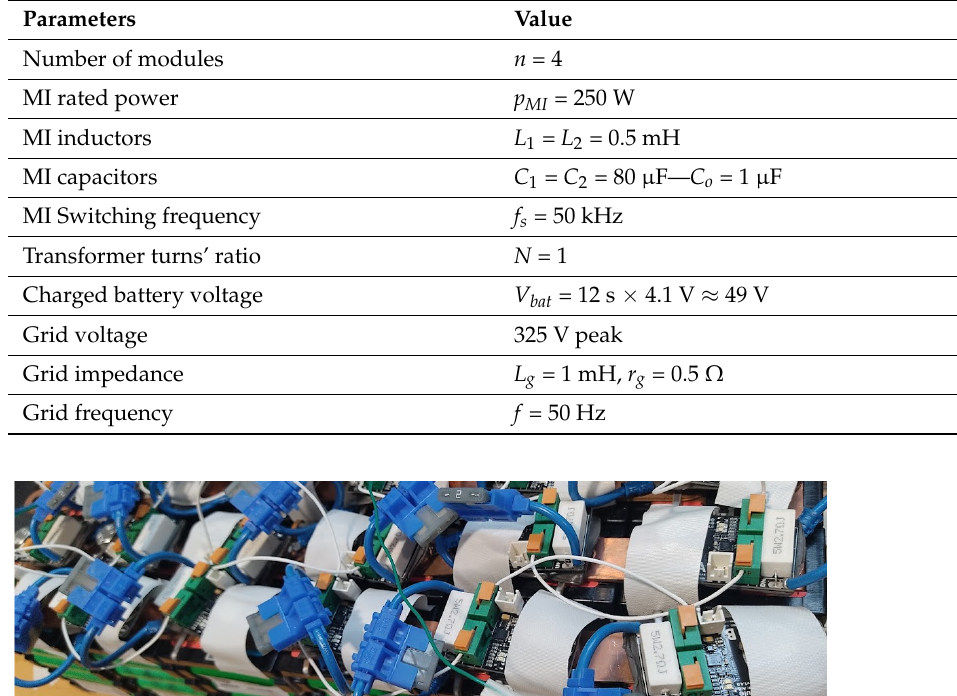
Figure 14. MCI experimental prototype. Table 1. Parameters of the MCI model.